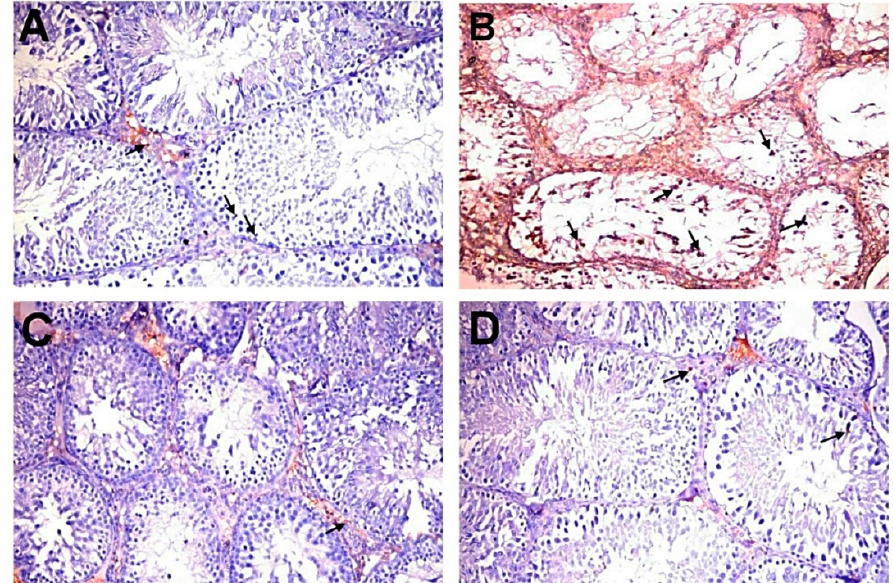
Figure 5. Immunohistochemical analysis of caspase-3 in experimental groups (200 × ). ( A ) NC group showing very weak immunopositive reaction (arrows). ( B ) DC group showing strong immunopositive reaction in germ, Sertoli (arrows), and Leydig cells. ( C , D ) D + MC-250 and D + MC-500 groups showing very weak immunoreactivity in spermatogenic (arrows) and Sertoli